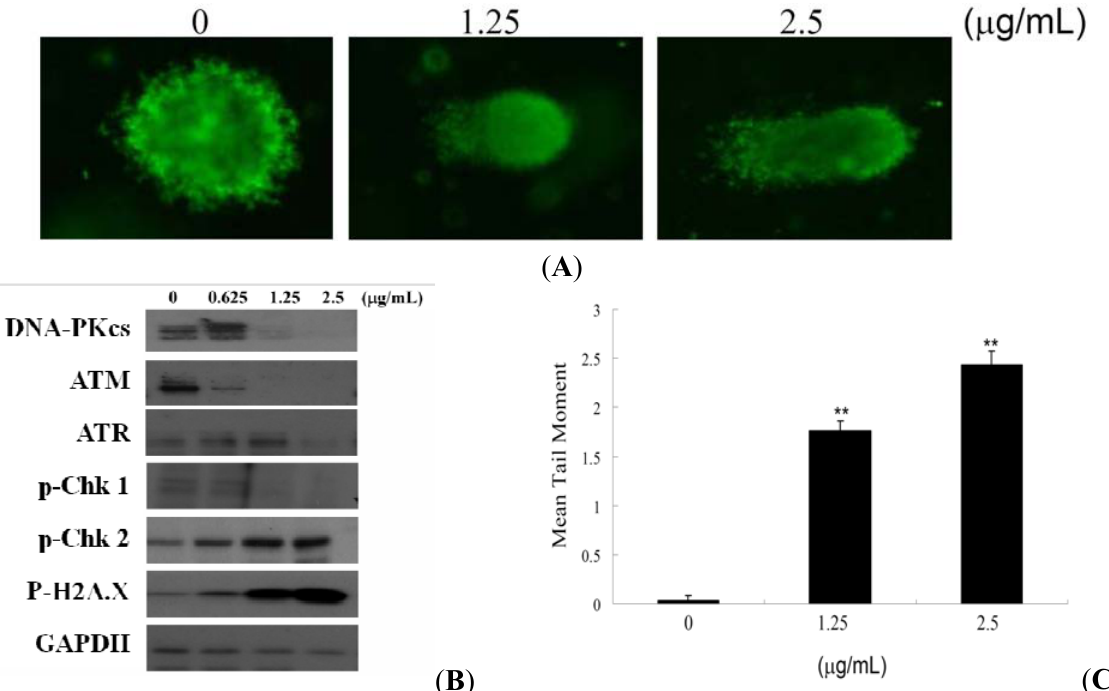
Figure 3. Effect of 10-acetylirciformonin B on the induction of double-strand breaks in HL 60 cells. ( A ) An example of “comet tail” due to chromosomal DNA double-strand breaks in 10-acetylirciformonin B (1.25 and 2.5 μ g/mL)-treated HL 60 cells compared to the untreated control. Electrophoresis was carried out under neutral conditions. ( B ) Cells were harvested